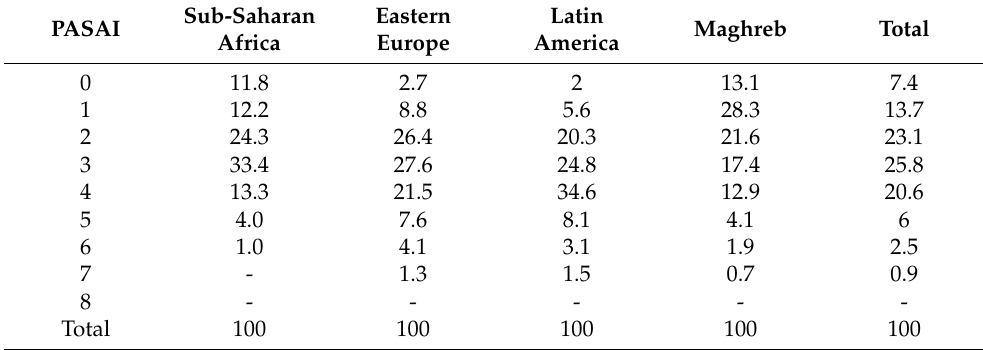
Table A4. PASAI according to origin (%).